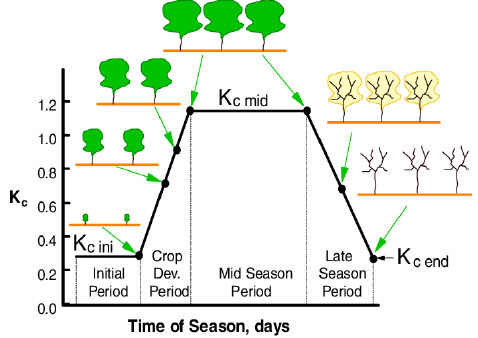
Figure 2. Generic curve of the crop coefficient ( K c ).